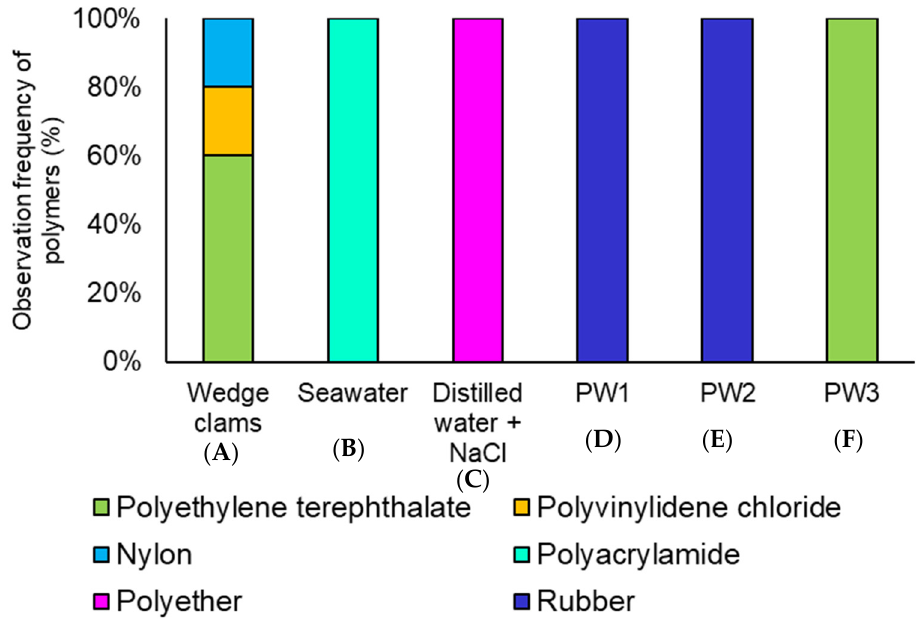
Figure 9. Frequency of polymers (%) identified using micro-FTIR in wedge clam specimens ( A ), seawater ( B ), distilled water + NaCl ( C ), purged water in 3 h ( D ), purged water in 6 h ( E ), purged water in 9 h ( F ).